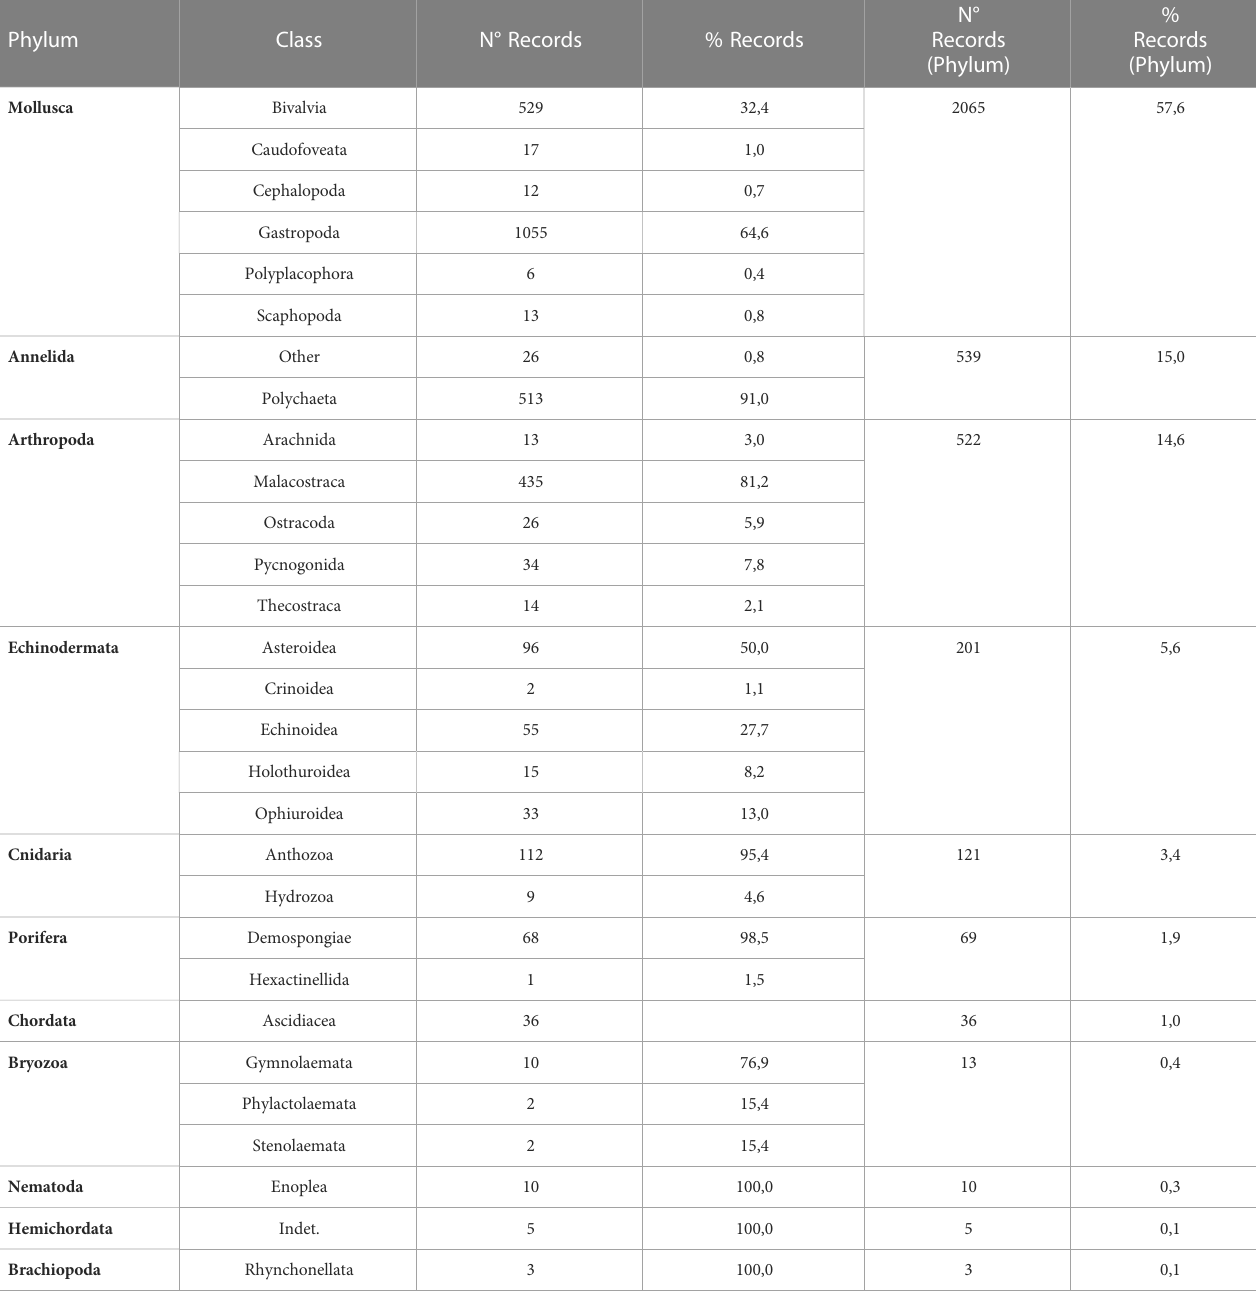
TABLE 1 Number and percentage of records included in the curated biological database, according to phylum and class.